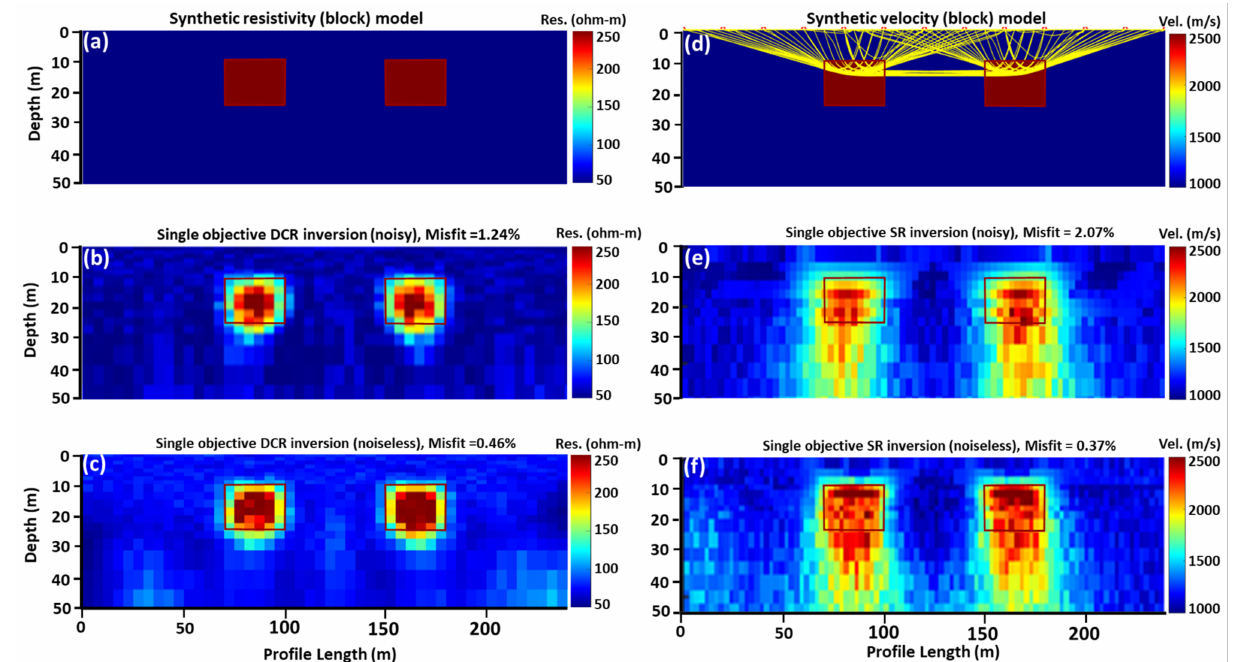
Figure 15. Test of the combined optimization algorithm using data (both DCR and SR) with added 3% gaussian noise; ( a ) synthetic dc-resistivity model, ( b ) single objective inverted resistivity model (noisy), ( c ) single objective inverted resistivity model (noiseless), ( d ) synthetic velocity model, ( e ) single objective inverted velocity model (noisy), and ( f ) single objective inverted velocity model (noiseless). The dark red lines are used to mark the anomaly boundary.